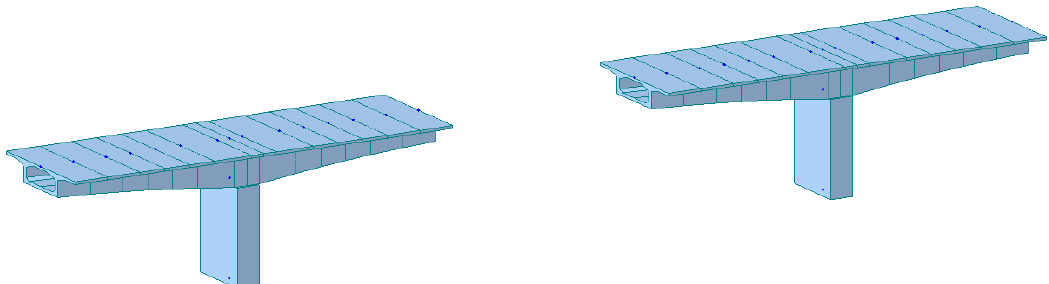
Appl. Sci. 2023 , 13 , x FOR PEER REVIEW 14 of 22